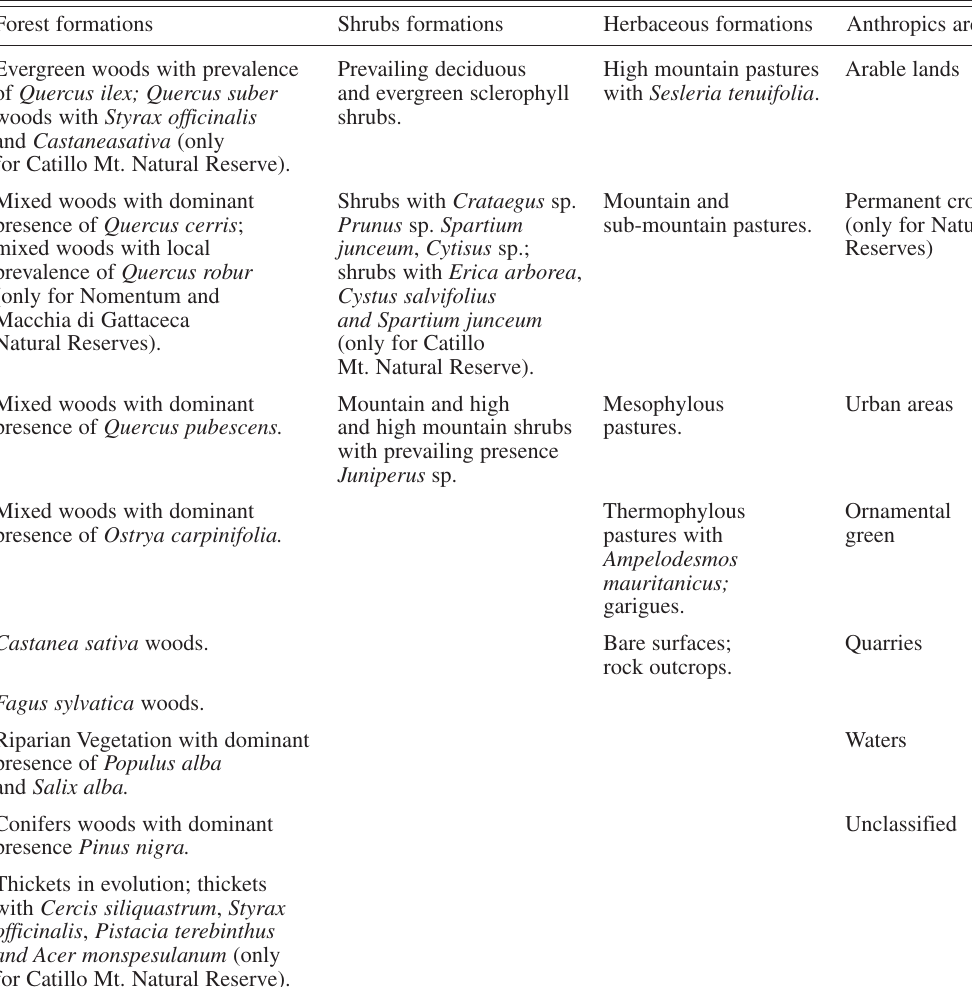
Table III. Definitions of prevailing vegetation classes. Forest formations Shrubs formations Herbaceous